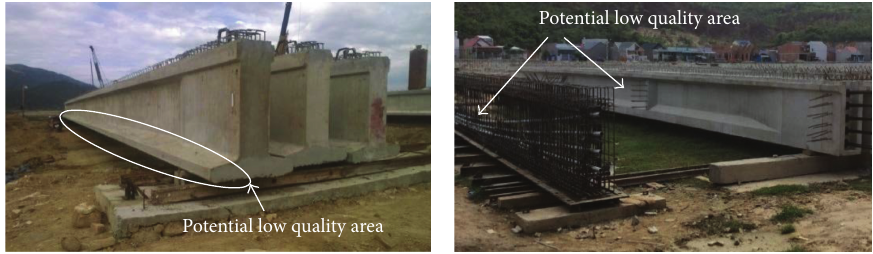
Figure 1: Examples of low quality areas seen during the process of